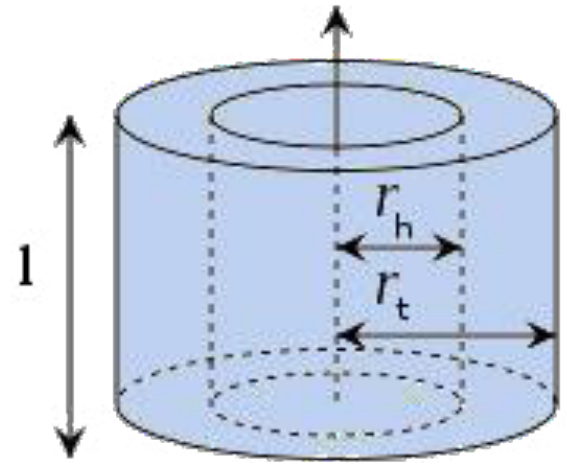
Figure 4. Simplified rotor blade model.